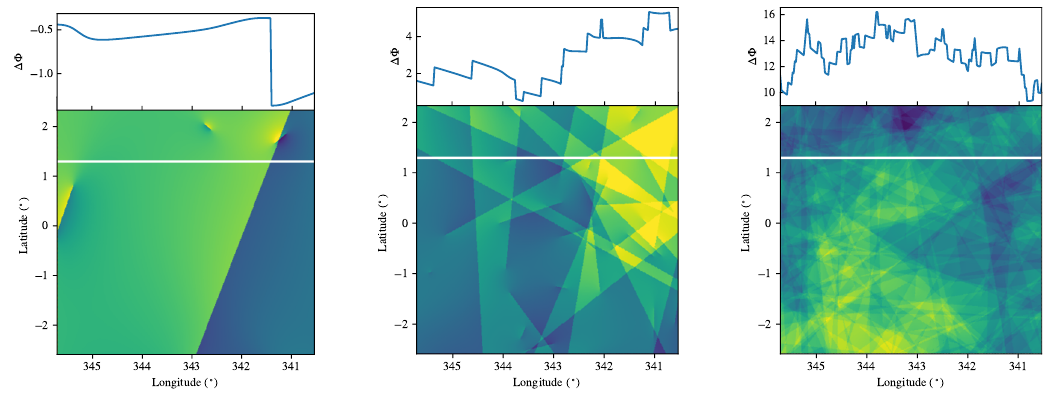
Figure 7 . Zoomed-in skymaps at the truth-level for (cid:24) = 1 ; 10 ; 100 showing the white framed areas in the respective skymaps in (cid:12)gure 4 (the color scale is modi(cid:12)ed for visual clarity). The presence of sharp discontinuities is apparent in these images of broken light. The discontinuity is quantized and is equal to 1. The white stripe shows a slice through the map, and the value of (cid:1)(cid:8) (normalized by 1 = ( A (cid:11) em )) is shown in the top panels where the quantized jump is